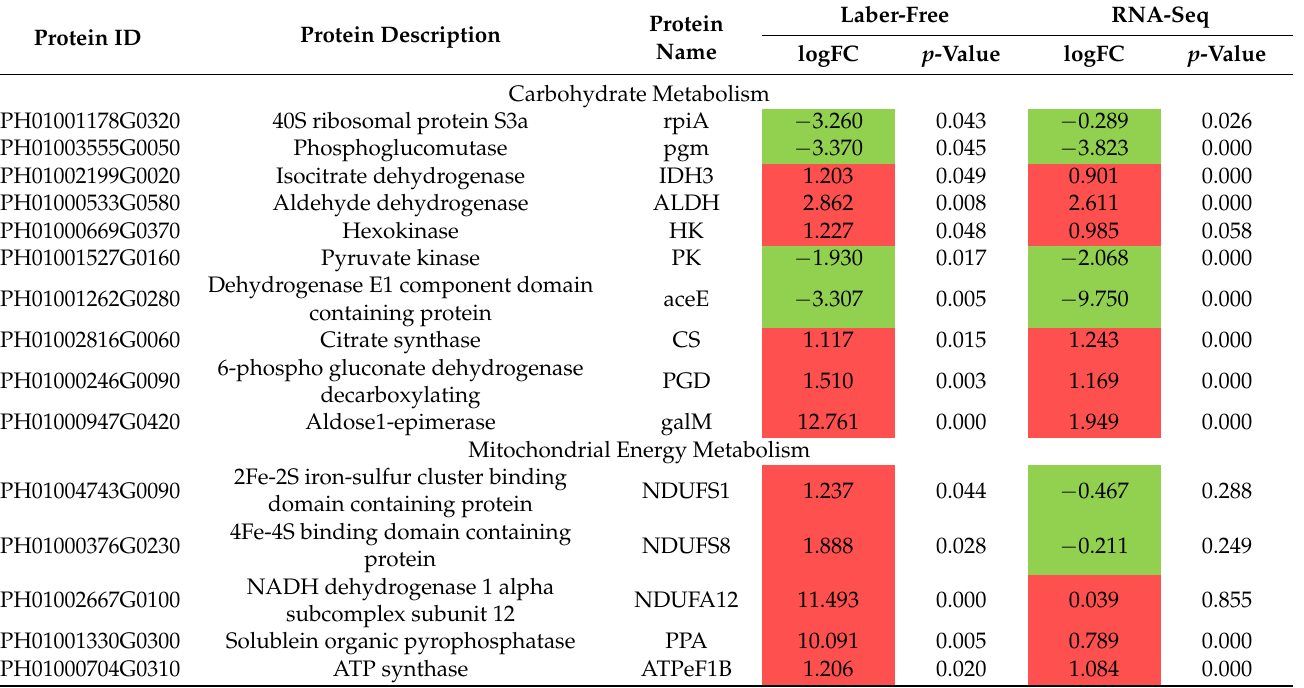
Table 1. DEPs Related to Carbohydrate and Mitochondrial Energy Metabolism in Total Proteome. Laber-Free Protein Protein ID Protein Description Name